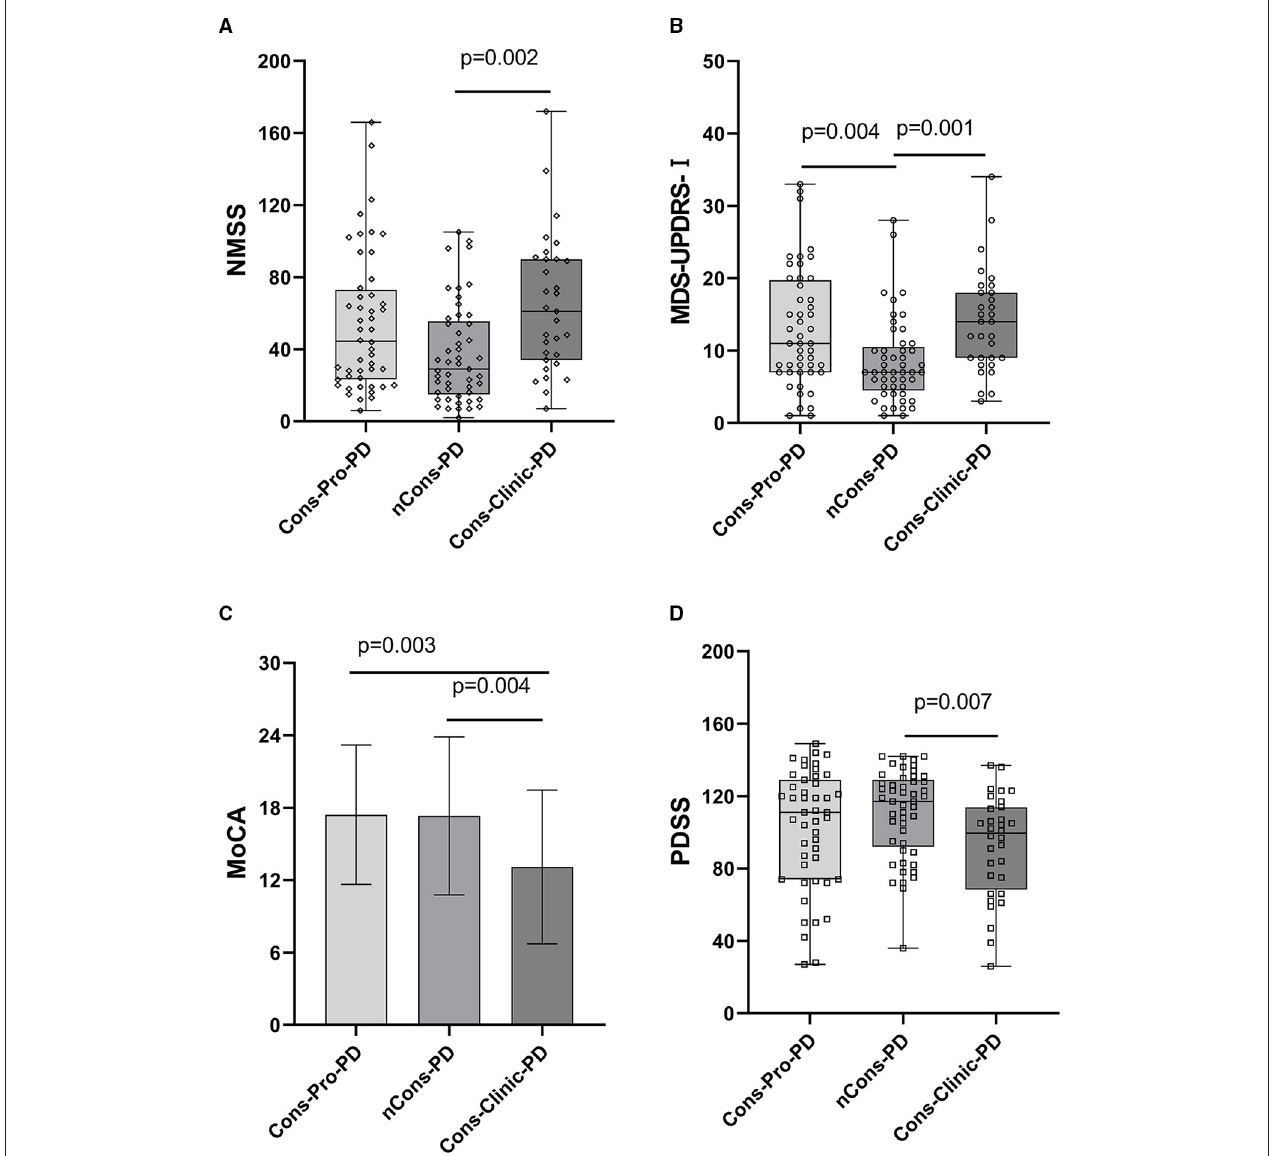
FIGURE 3 | (A) Revealed that the median NMSS score of the Cons-Clinic-PD group (M 61,QR 34–90) was higher than that of the nCons-PD group (M 29,QR 15–55.5, p = 0.002), although no statistically significant difference was observed in nCons-PD (M 29, QR 15–55.5, p > 0.05) and Cons-Clinic-PD (M 61, QR 34–90 p > 0.05). (B) Revealed that the median MDS-UPDRS-I in the nCons-PD group (M 7,QR 4.5–10.5) was lower than in the Cons-Pro-PD group (M 11, QR 7–19.75, p = 0.004) and Cons-Clinic-PD group ( p = 0.001), and no statistical difference was found between the Cons-pro-PD and Cons-clinic-PD groups ( P > 0.05). (C) Indicates that the mean MoCA of the Cons-Clinic-PD group was 13.10 (SD 6.37) lower than the Cons-Pro-PD group, which was 17.42 (SD 5.78 p = 0.003) and 17.33 (SD 6.56, p = 0.004). There was no substantial difference in the course of disease between the Cons-pro-PD and nCons-PD groups ( p > 0.05). (D) Revealed that the median PDSS score of the Cons-Clinic-PD group (M 98,QR 66–113) was lower than the nCons-PD group (M 117, QR 92–129, p = 0.007), and no statistically significant difference was observed in nCons-PD (M117, QR 92–129 p > 0.05) and Cosn-Clinic-PD (M 98, QR 66–113, p > 0.05). group. There was no statistically significant difference ( p >